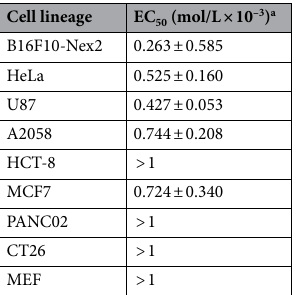
Table 1. Antiproliferative activity of Rb4 peptide on tumor cell lines and non-tumor forming cell lines, ± standard deviation (s.d.). a EC 50 is the concentration that decreases viability by 50% in a dose-dependent survival curve.